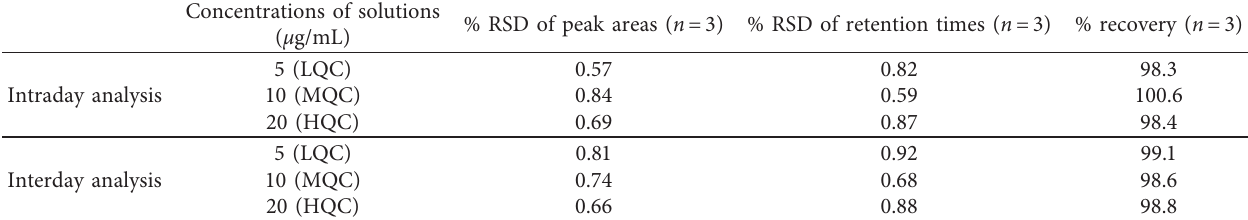
Table 1: Precision and accuracy results for intraday and interday analysis of caffeine by the proposed method. Concentrations of solutions